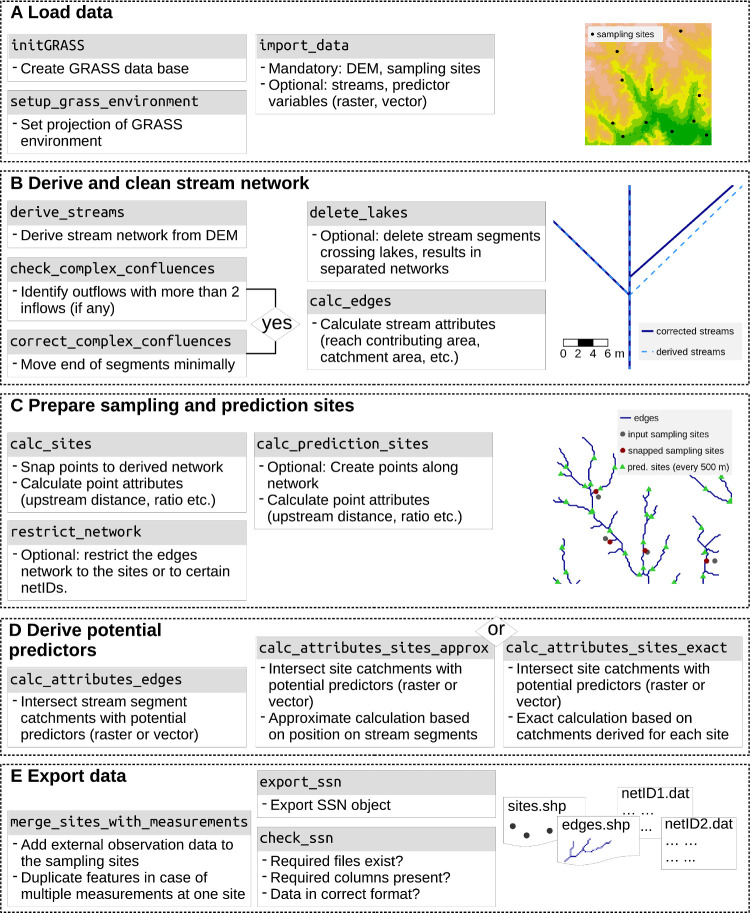
openSTARS workflow.